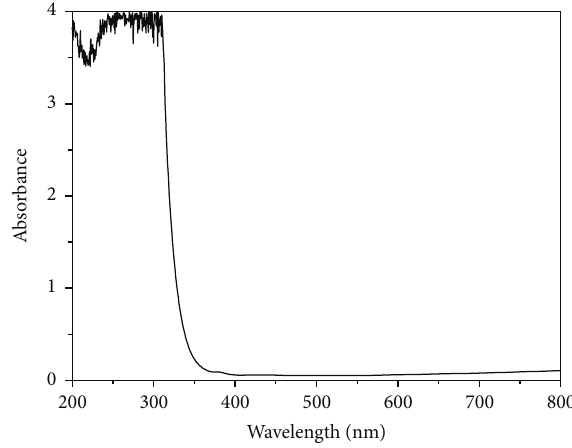
Figure 1: The absorbance spectrum of the